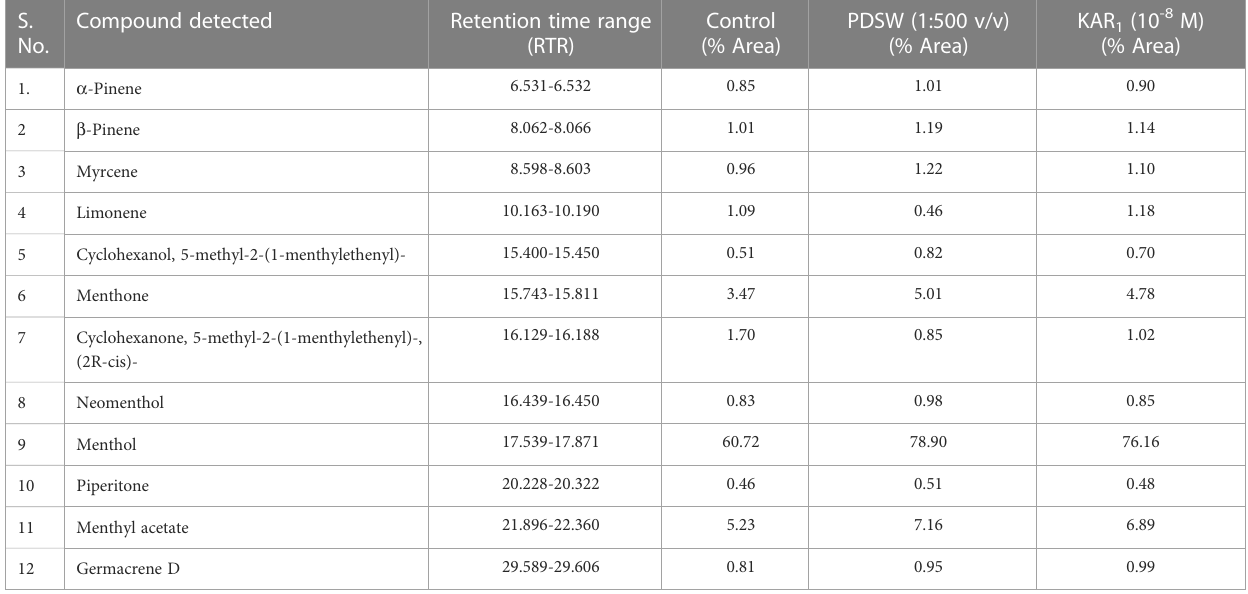
TABLE 3 Effect of foliar application with PDSW and KAR 1 on TIC (Total ion chromatogram) of the essential oil composition measured by GCMS on the leaves of Mentha arvensis L. at 90 DAP (days after plantation). S. No.